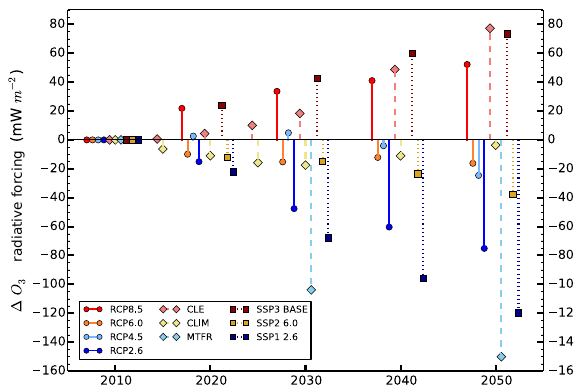
Figure 12. Parameterised response in the global annual mean ozone radiative forcing relative to 2010 for the different CMIP5 RCPs (cir- cles), ECLIPSE scenarios (diamonds) and CMIP6 SSPs